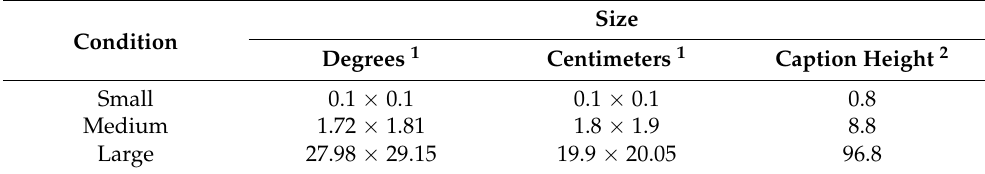
Table 1. Values of the stimulus size